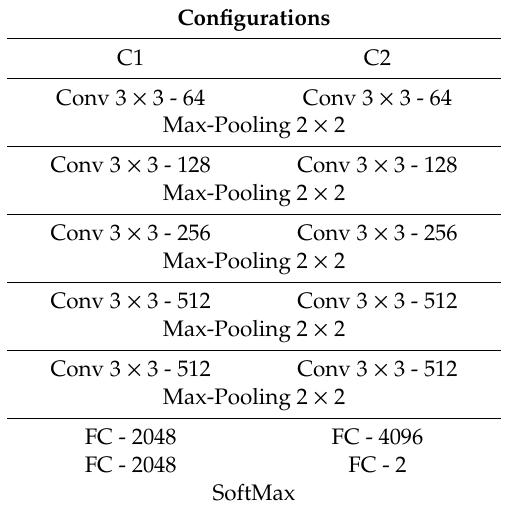
Table 1. Proposed networks based on VGG Net—Using half of the database. FC: fully connected.